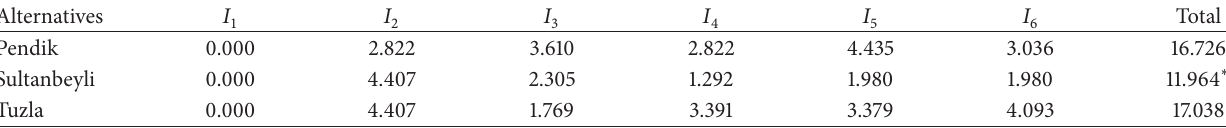
Table 9: Unit Index for unweighted information contents for Asian Side of Istanbul.